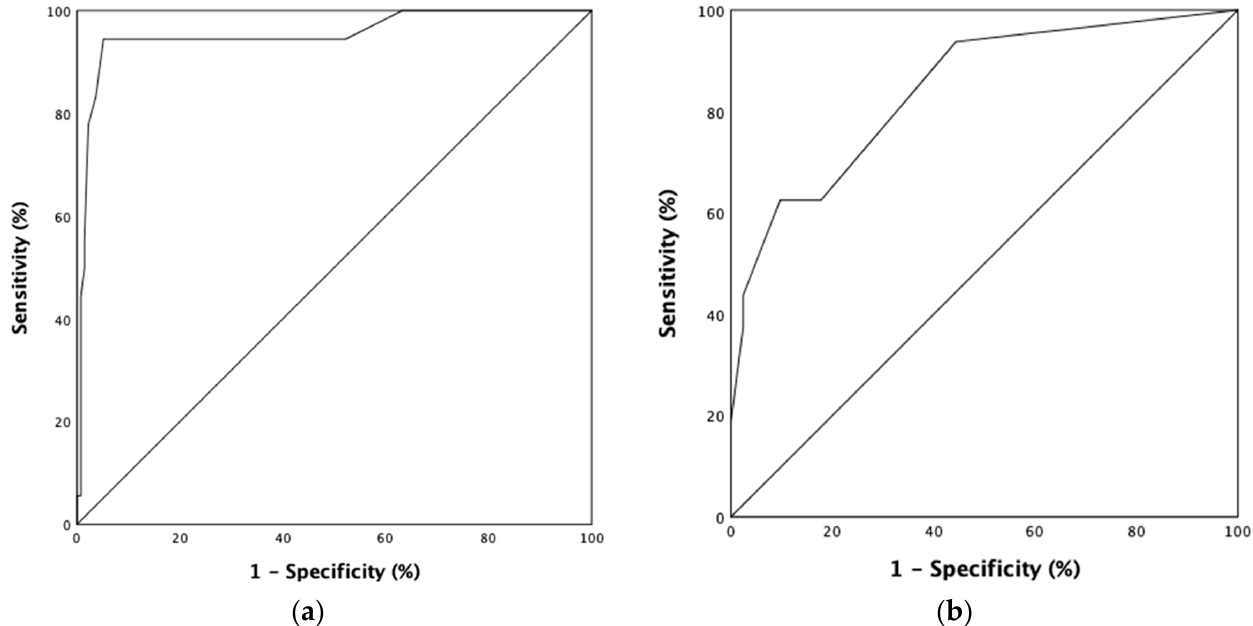
Figure 2. ROC curve for the best cutoff value of tumor size and Ki-67 predicting nodal involvement. ( a ) Area under ROC curve (AUROC) for tumor size: 0.953; 95% confidence interval: 0.891–1.000; standard error: 0.032; cutoff value: 11.5 mm; ( b ) area under ROC curve (AUROC) for Ki-67: 0.843; 95% confidence interval: 0.737–0.949; standard error: 0.054; cutoff value: 3.5%.